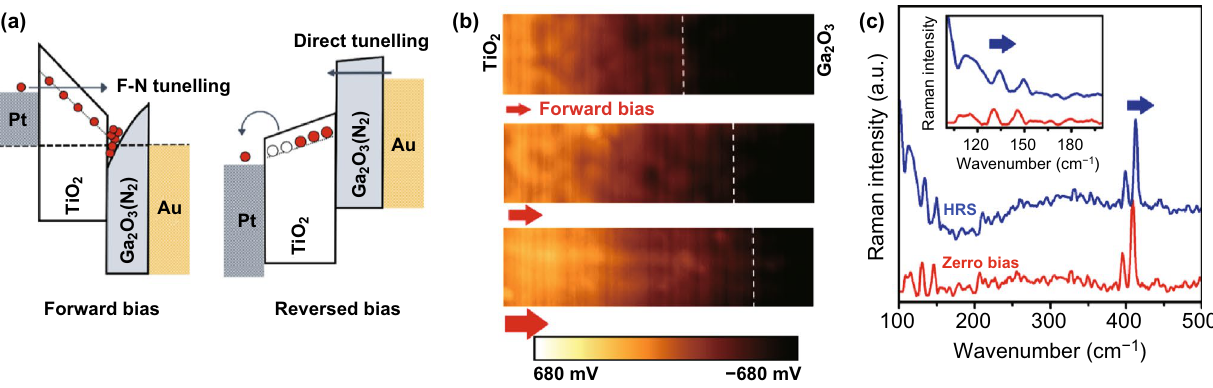
Fig. 6 a Schematic band diagram for charge transfer from TiO 2 to Ga 2 O 3 (N 2 ) devices. b KPFM analysis monitors the surface potential of mem- ristor device between Au and Pt electrodes for a horizontally developed TiO 2 –Ga 2 O 3 heterostructure. The scanning area was 1 μm 2 . The bright area represents the electron trap regions, and the dark area depicts the hole trap regions. c Raman spectra of TiO 2 film of memristor device in zero bias and HRS